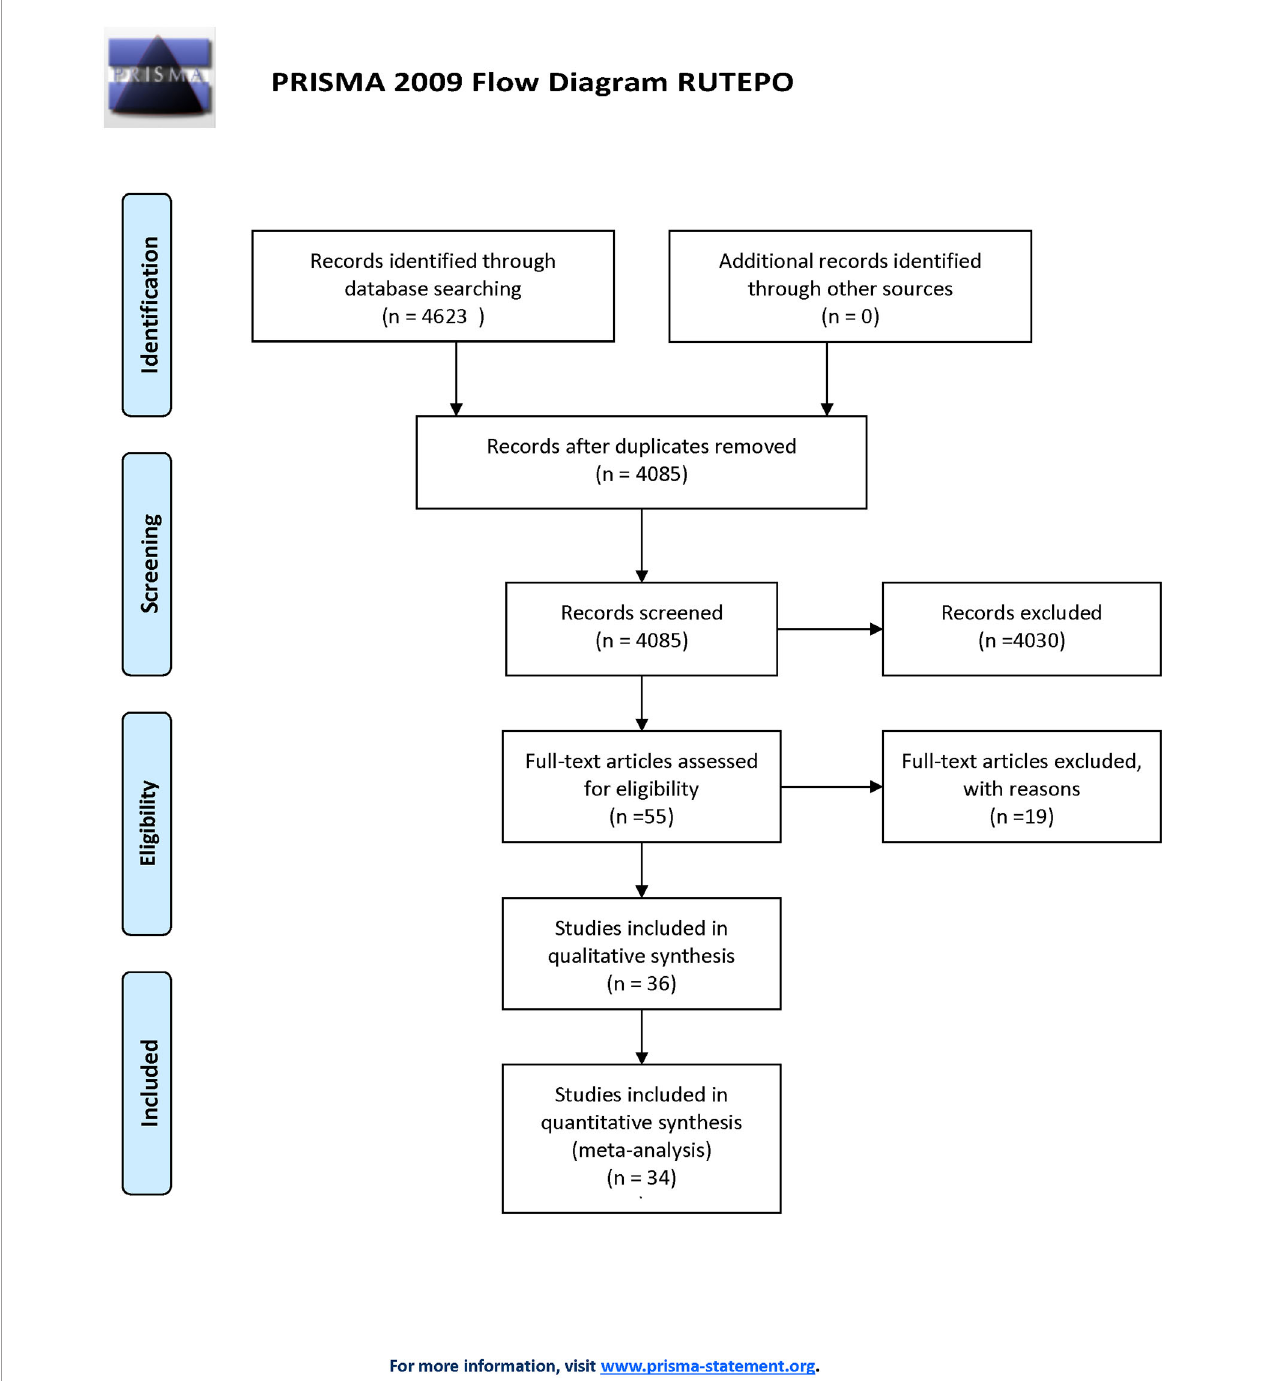
FIGURE 1 | PRISMA fl owchart of study